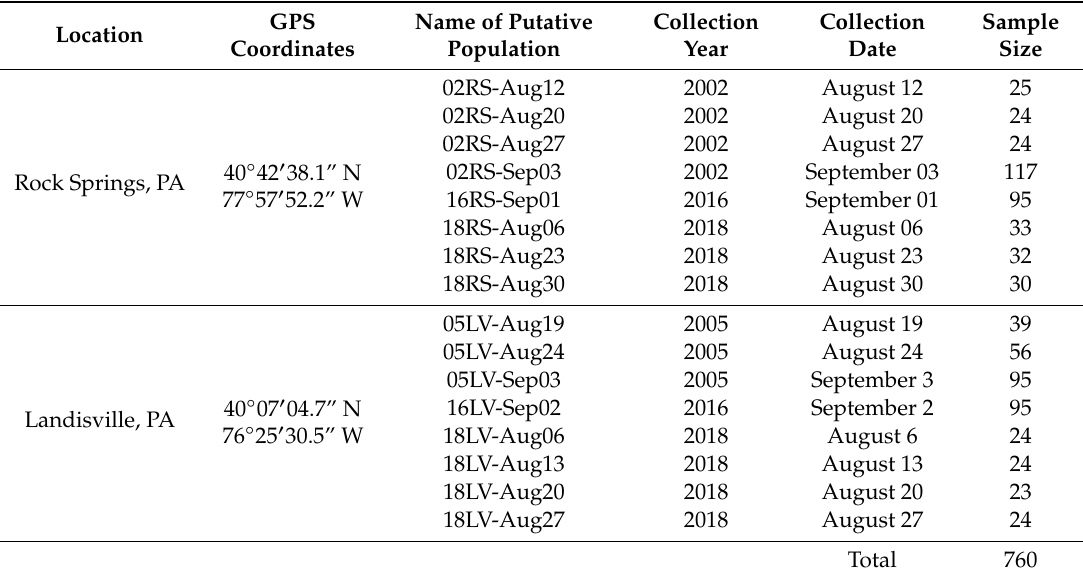
Table 1. Collection sites, Global Positioning System (GPS) coordinates, collection year and date, and the sample size of putative populations of Helicoverpa zea used in this study. The first two digits of the population name represents the collection year and the next two letters represent the collection site followed by the collection date. Rock Springs (RS), Landisville